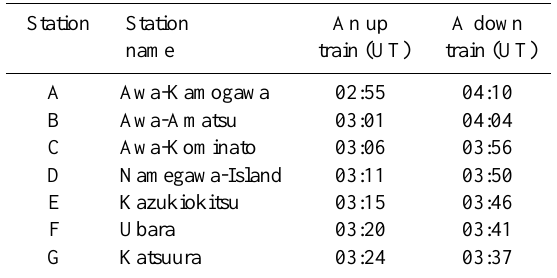
Table 3. Railway stations and the timetable from 02:55 to